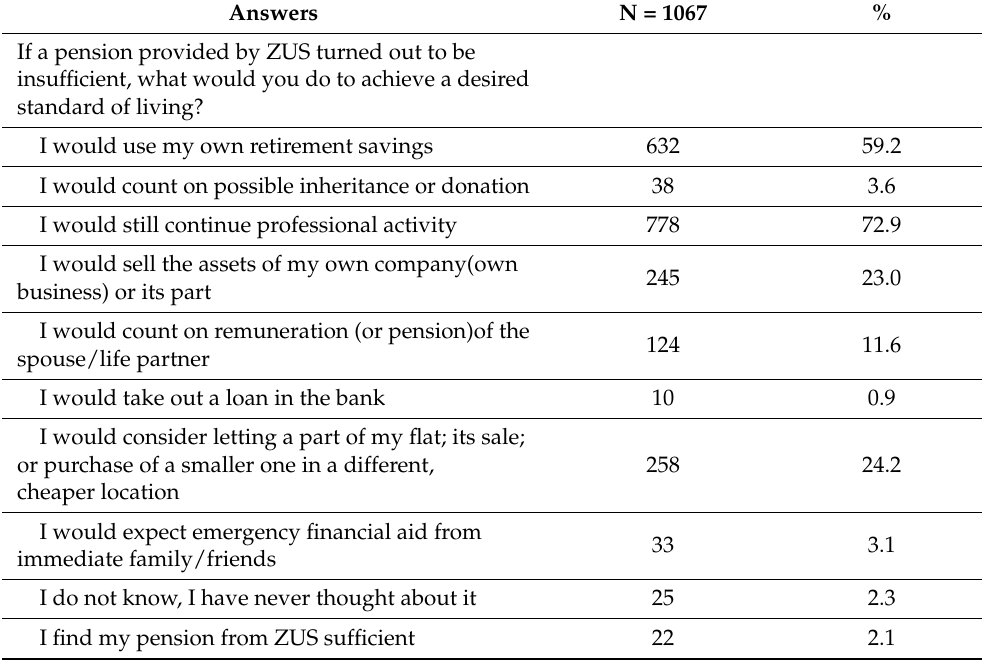
Table 2. Planned strategies of respondents, if the pension from the public pillar turned out to be too